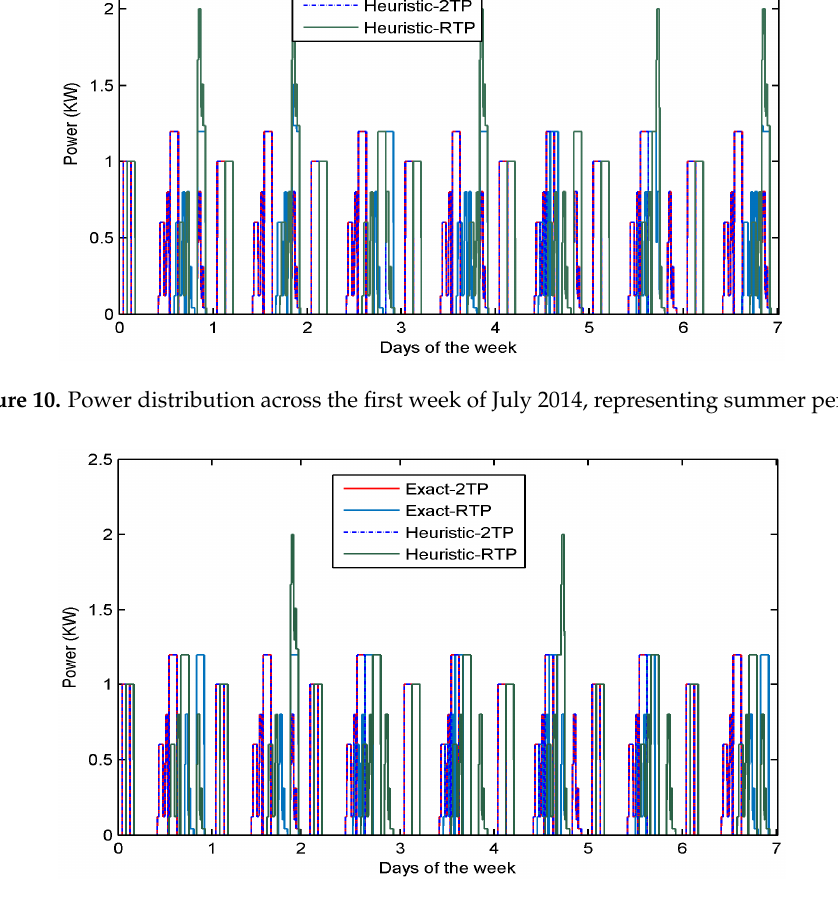
Figure 11. Power distribution across the first week of October 2014, representing autumn period.